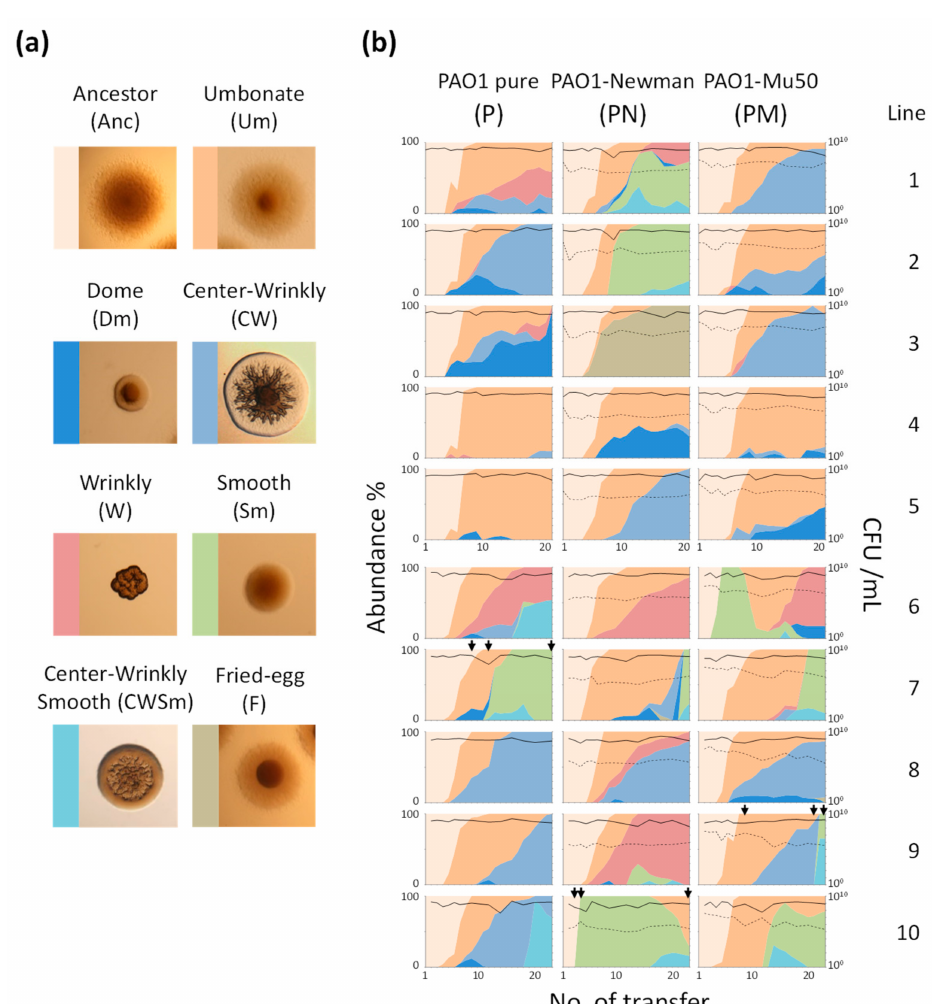
Figure 1. Evolutionary and population dynamics of Pseudomonas aeruginosa . ( a ) Typical colony morphologies of major colony morphology variants (CMVs). ( b ) Transition of population size and abundance of CMVs. Area plots indicate proportion of each CMV, and colors correspond to CMVs shown in (a). Solid lines and dashed lines indicate viable cell number (CFU/mL) of PAO1 and each S. aureus strain, respectively. Missing data point was interpolated by connecting the value at before and after gap to create smooth area plots. Complete data sets were provided in Supplementary Figure S1. Total numbers of transfer were 21 and 23 for Line 1 to 5 and Line 6 to 10, respectively. Black arrows indicate time points at which the concentration of temperate phage in the culture supernatant was